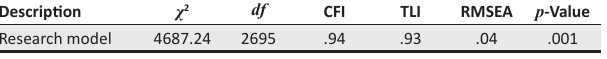
TABLE 2 : Results of the Structural equation modelling (SEM) analysis ( n = 593).